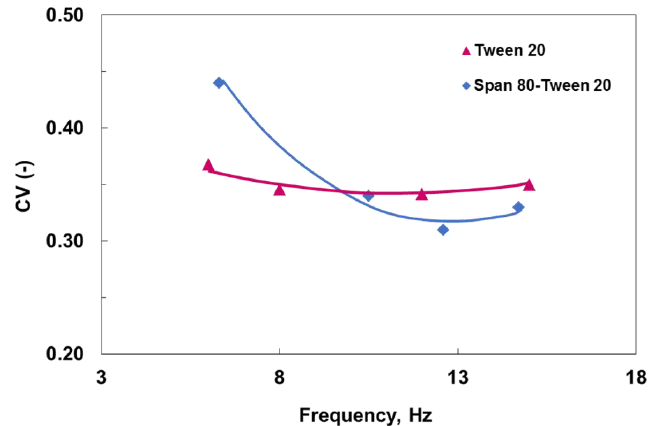
Figure 4. Change in coefficient of variation (CV) with oscillation frequency for surfactant-stabilized emulsions. Dispersed phase flux J = 30 L·m −2 ·h −1 (LMH), oscillation amplitude, a = 10 mm.